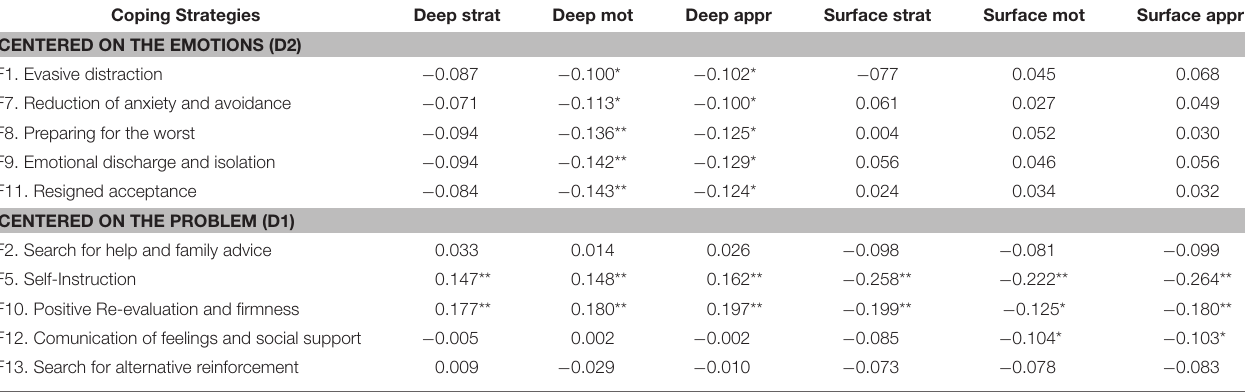
Table 6 | Bivariate correlation between the variables of learning approach with coping strategies by dimensions and factors.